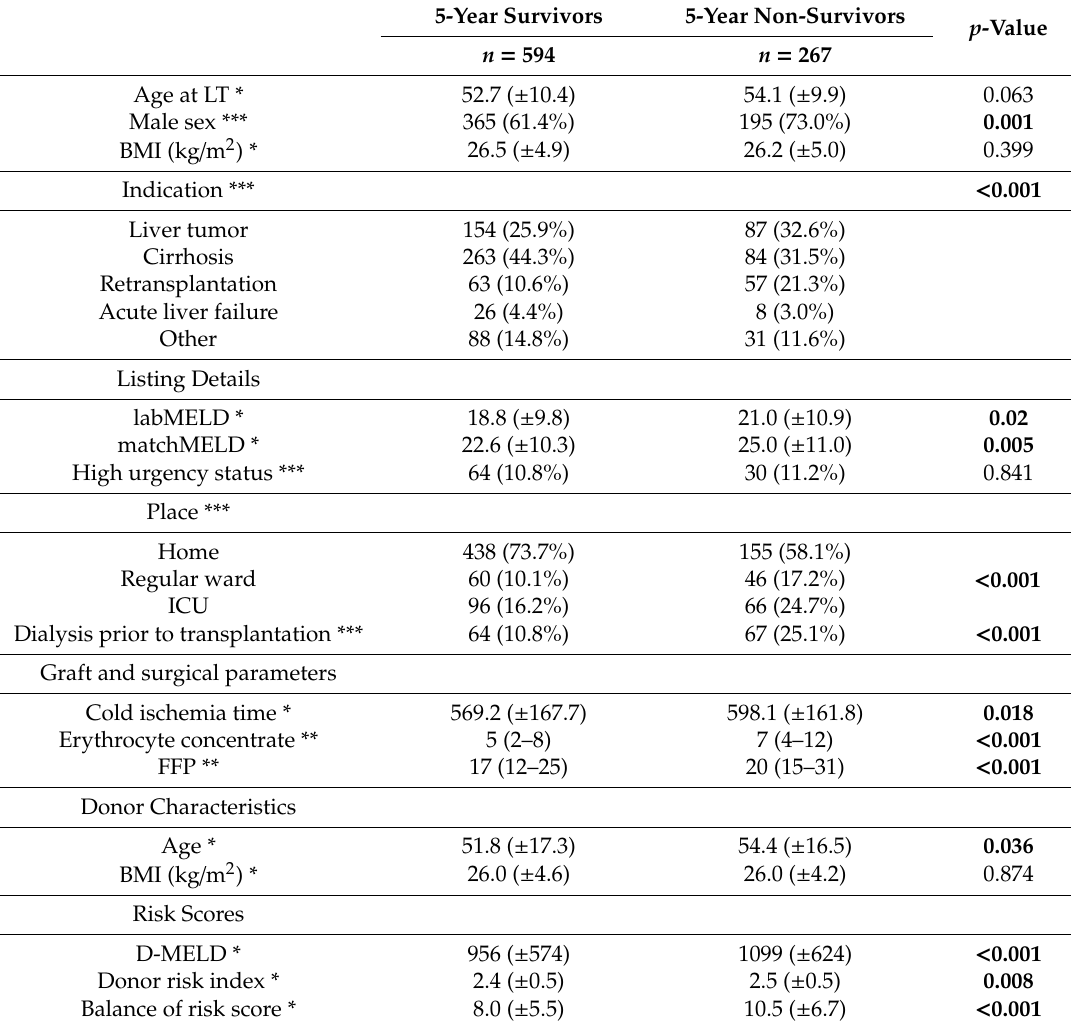
Table 2. Characteristics of 5-year survivors and